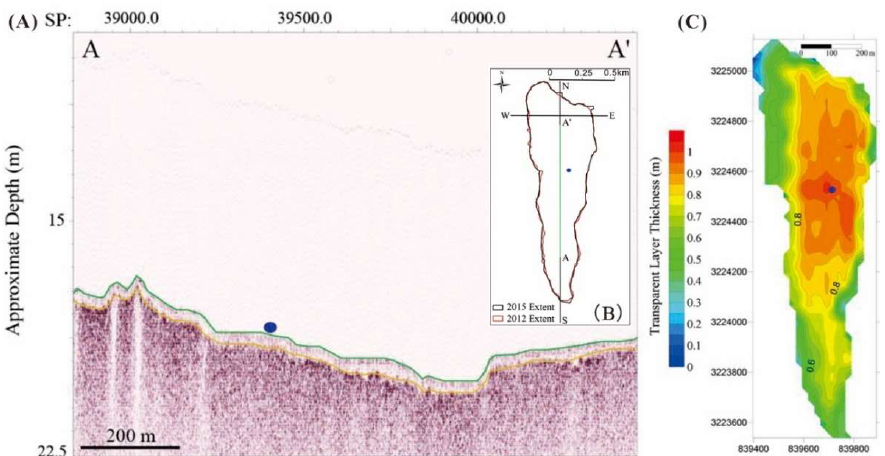
Figure 5. ( A ) Sub-bottom seismic profile of A–A’ (see inset (B)): inspective ‘high turbidity’ layer between green and orange lines; ( B ) the edge of Sandy Point dredging pit in 2012 and 2015, and station T2 (blue dot); ( C ) thickness isopach of the ‘high turbidity’ layer on the pit bottom, with UTM x–y coordinate of zone 16 (in meters), and T2 station (blue dot on both panels).